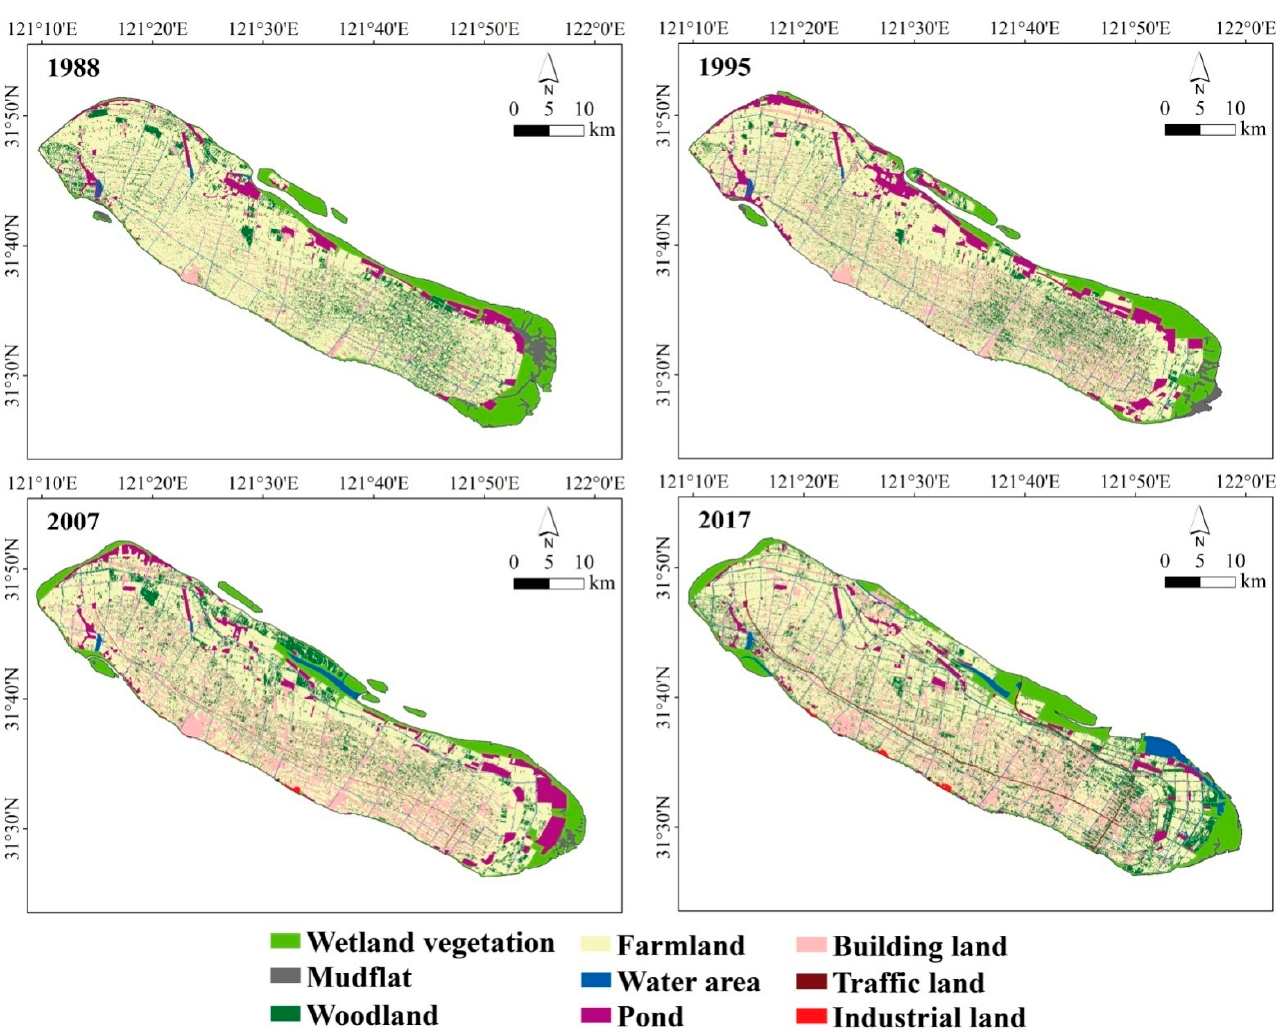
Figure 3. Land-cover types of the study area in different years [59].